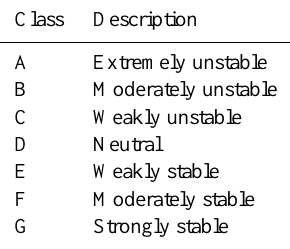
Table 1. Pasquill–Gifford stability class names. Table 2. Lateral turbulence criteria; step 1 of P–G turbulence stabil- ity